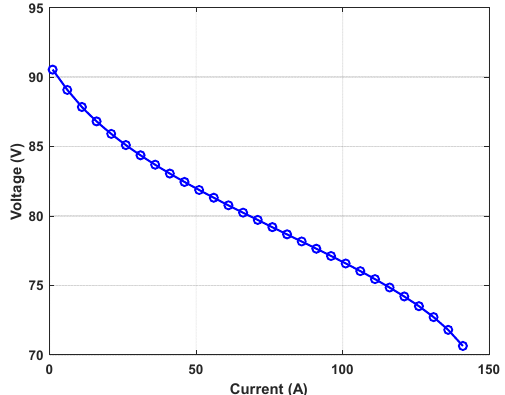
Figure 11. Datasets for validation for electrochemical model.